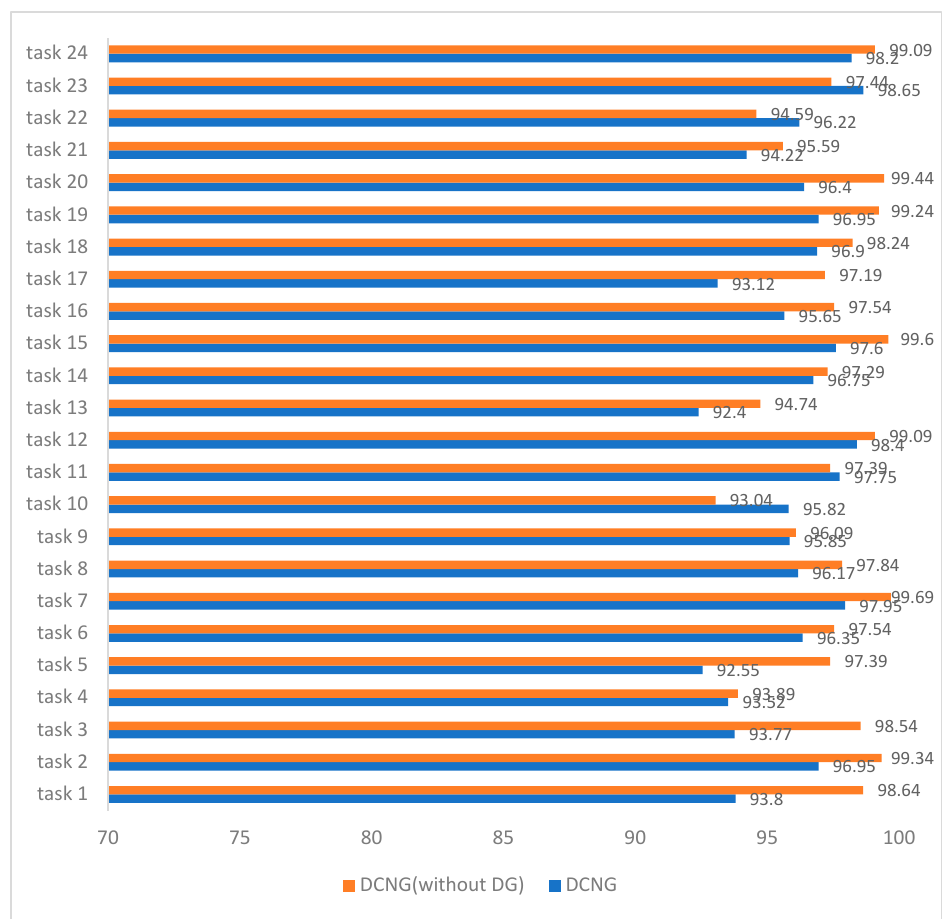
Figure 12. DCNG and ungeneralized model performance on 24 tasks in the CWRU dataset.